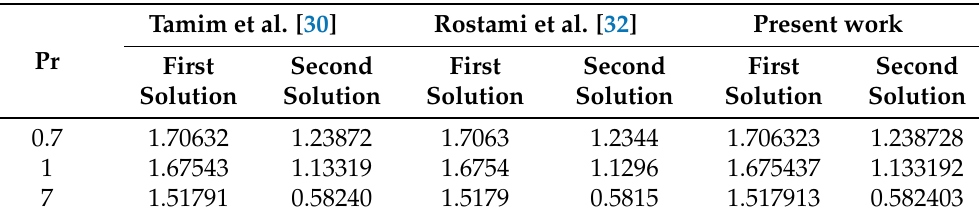
Table 3. Comparison values of f (cid:48)(cid:48) ( 0 ) for multiple values of Prandtl number when Rd = S = ϕ 1 = ϕ 2 = 0 and λ = 1.